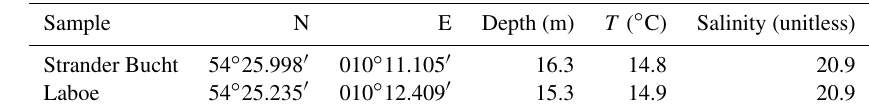
Table 1. Information of the sampling points. 1: Strander Bucht, 2: Laboe.